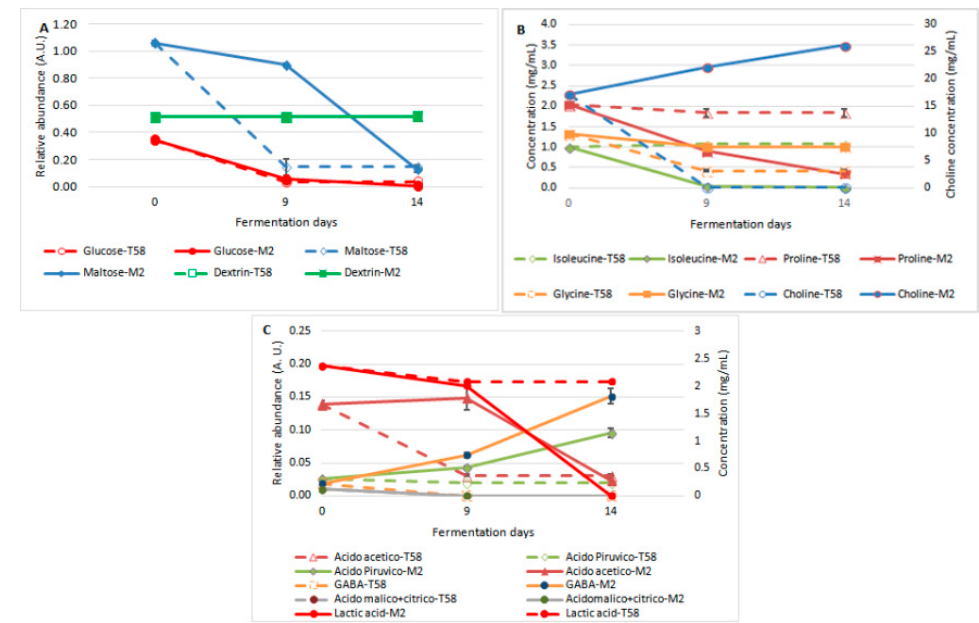
Figure 2. Wort fermented by H. uvarum L2 and S. cerevisiae US-05 (M2) and wort fermented by S. cerevisiae T-58 (T58): ( A ) Time evolution of the main carbohydrates (glucose, maltose, dextrin) levels (arbitrary units); ( B ) time evolution of amino acid and choline content (mg/mL); ( C ) time evolution of organic acids content (mg/mL or arbitrary units). Data are reported as means ± SD of two measurements. Where not visible, error bars lie below the symbols.